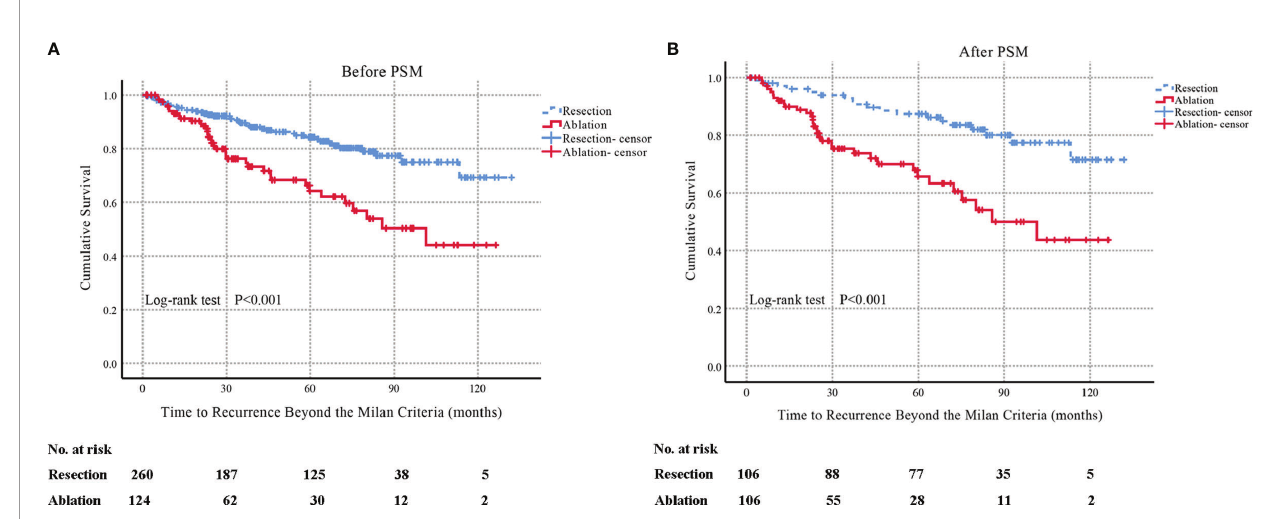
FIGURE 2 | Before one-to-one PSM, Kaplan – Meier curves of TRBM in patients with single-nodule HBV-associated HCC of 2 – 3 cm who underwent resection or accepted ablation (resection group: n = 260; the median TRBM, not available; 95% CI: not available; ablation group: n = 124; the median TRBM, 101.4 months; 95% CI: 67.3 – 135.5 months; P < 0.001) (A) . After one-to-one PSM, Kaplan – Meier curves of TRBM in patients with single-nodule HBV-associated HCC of 2 – 3 cm who underwent resection or accepted ablation (resection group: n = 106; the median TRBM, not available; 95% CI: not available; ablation group: n = 106; the median TRBM, 85.7 months; 95% CI: 57.2 – 114.2 months; P < 0.001) (B) . TRBM, time to recurrence beyond the Milan criteria; PSM, propensity score matching; HBV, hepatitis B